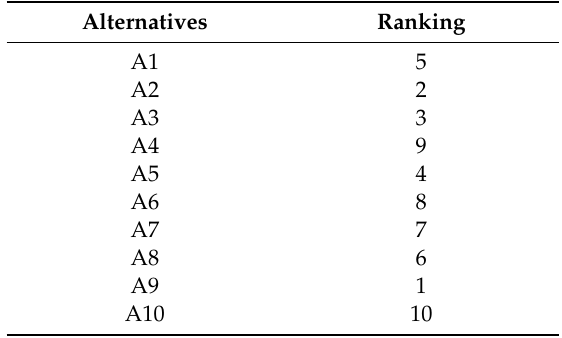
Table 17. Ranking of